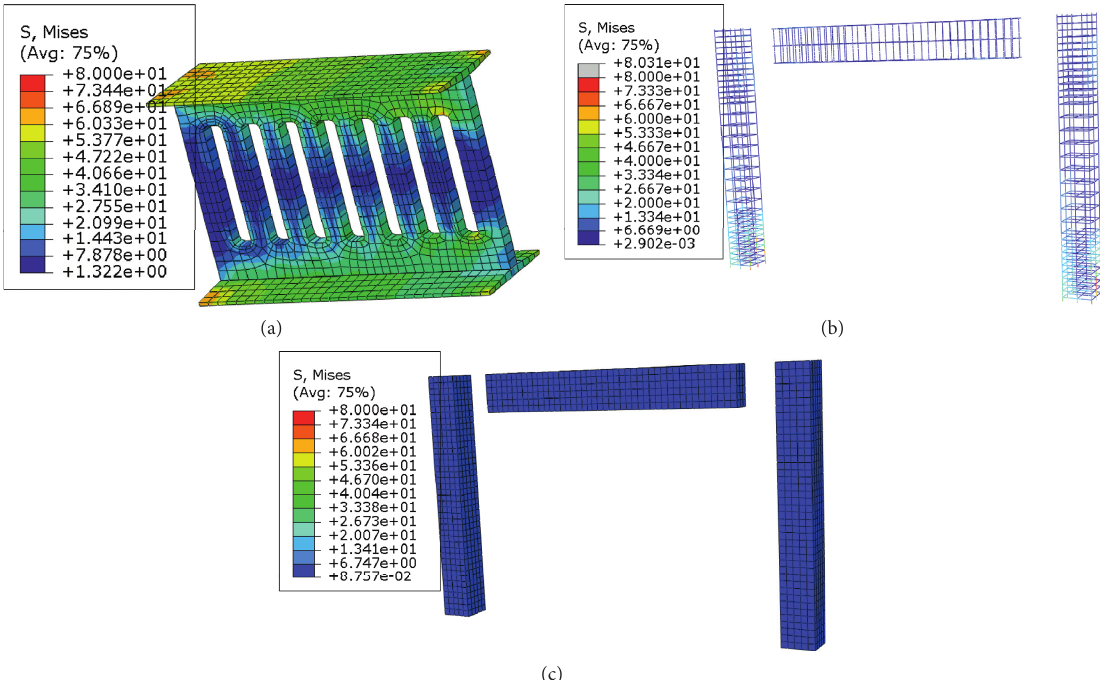
Figure 7: Stress nephograms of the damper, steel bar, and concrete at the horizontal drift of 3.9mm. (a) Stress nephogram of the damper. (b) Stress nephogram of the steel bar. (c) Stress nephogram of the concrete.